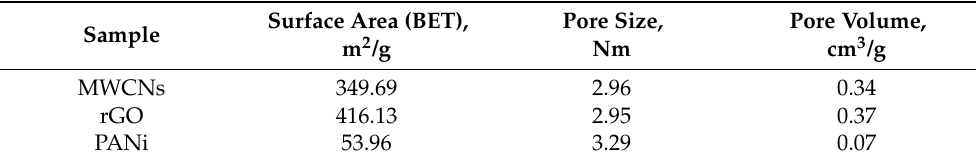
Table 2. Specific surface area (BET), pore size and pore volume of PANi, MWCNs and rGO.